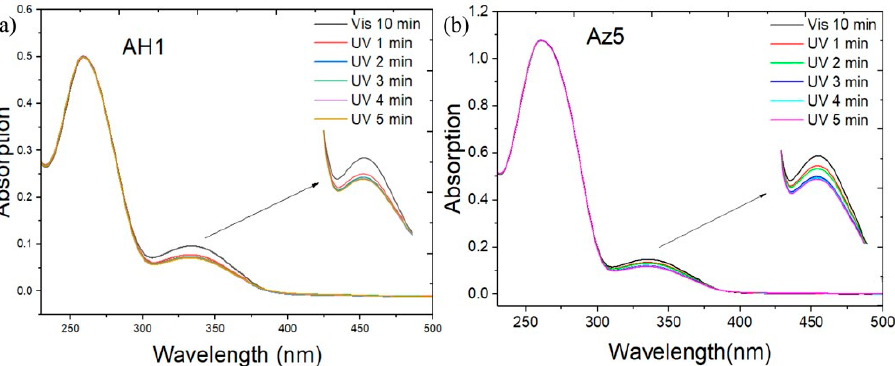
Figure 2. Photoisomerization of azobenzene-modified DNAs with UV or visible irradiation. The DNA sequences were ( a ) AH1: 5 ′ -AAAGazoCTTT-3 ′ and ( b ) Az5: 5 ′ -CGTTGazoCAACGTTTCGGACCGTATazoATACG-3 ′ , respectively. The samples were irradiated for various times (1 min, 2 min, 3 min, 4 min and 5 min) with UV light at 365 nm or for 10 min with visible light.